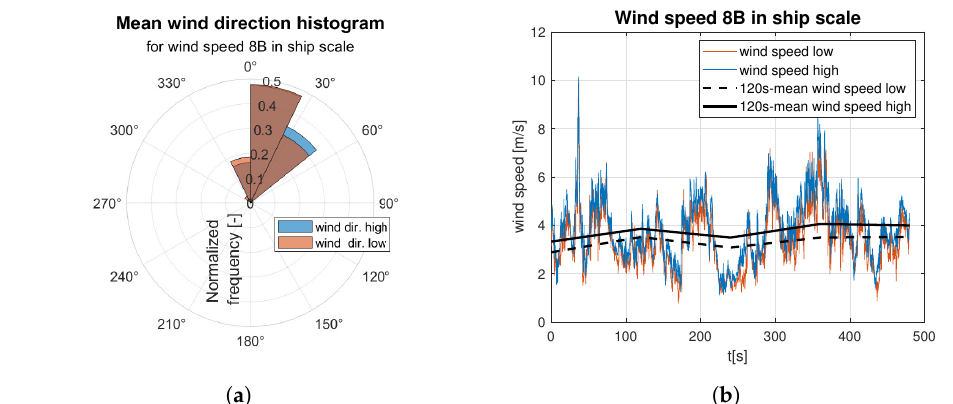
Figure 12. Raw measurements for medium strong wind—8BFT in ship scale: ( a ) wind rose; ( b ) time series.